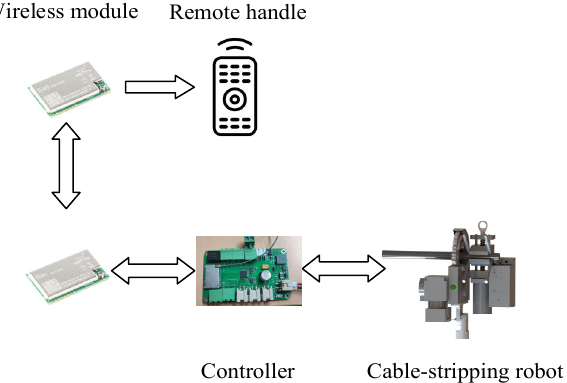
out 3 Figure 4. Motion control scheme of the cable- stripping robot.